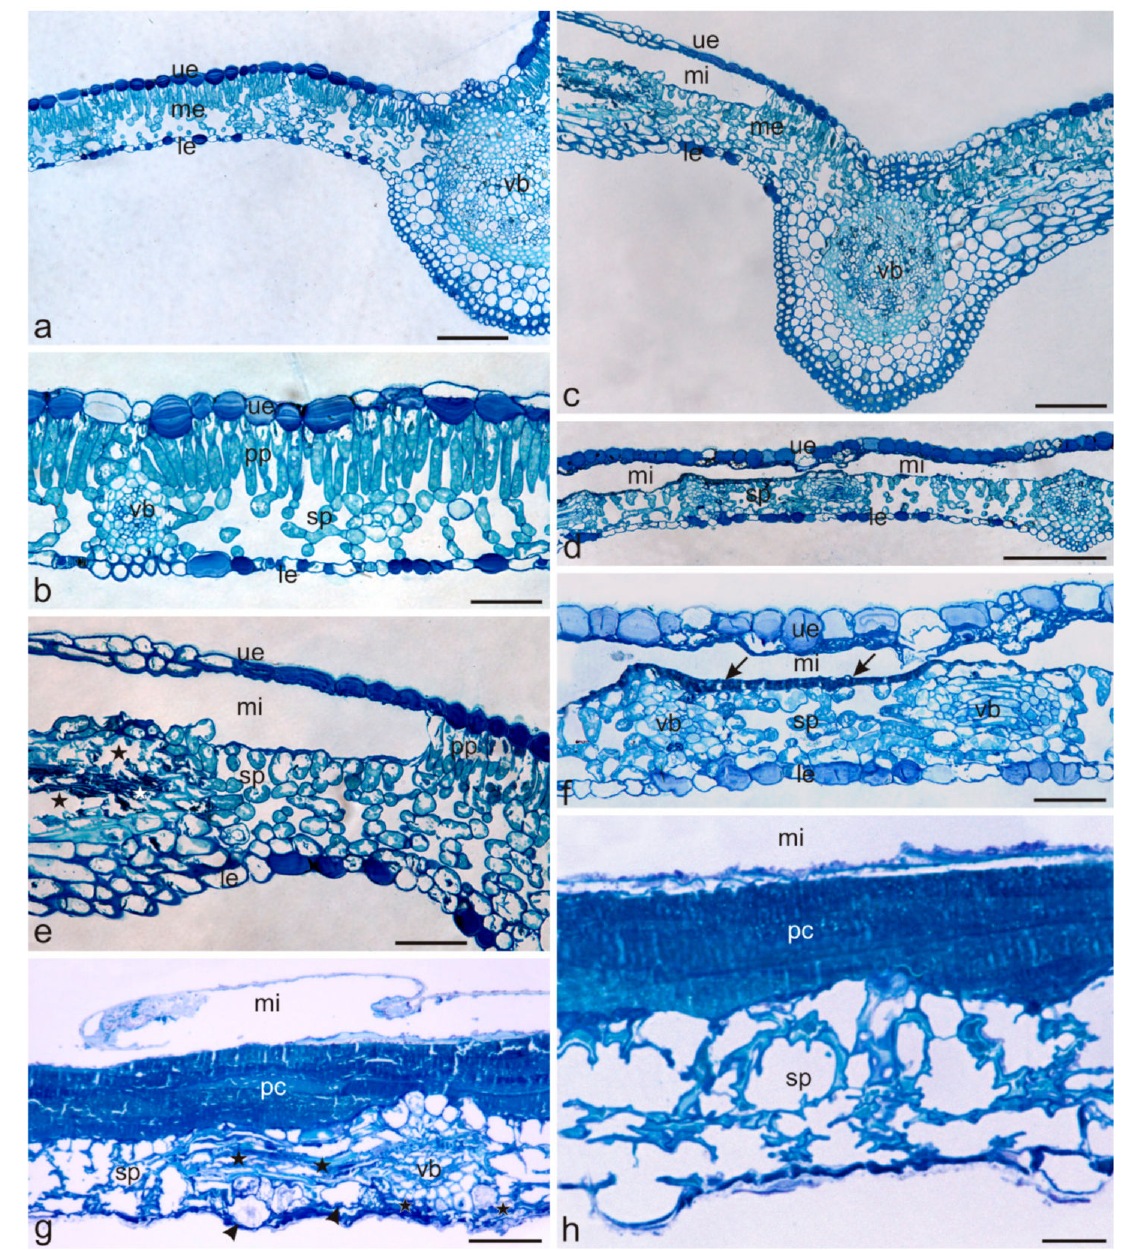
Figure 5. Cross-sections of Cameraria ohridella -infested and uninfested Aesculus hippocastanum leaves. ( a , b ) Uninfested (healthy) leaves with the adaxial (upper) and abaxial (lower) epidermis, mesophyll composed of a palisade and spongy parenchyma, and collateral vascular bundles. ( c – f ) Infested (damaged) leaves collected in July. ( c , d ) Visible mines at the sites of foraged palisade parenchyma. ( e ) Damaged spongy parenchyma cell walls in the vicinity of the mine (asterisks). ( f ), A thin, dark blue layer containing phenolic compounds visible on the bottom of the mine (arrows). ( g , h ) Infested leaves collected in September. ( g ) A substantially thickened amorphous layer containing phenolic compounds visible in the bottom of the mine. Note the cellular hypertrophy (arrows), the thick- ened walls, and the disturbed cell arrangement of the spongy parenchyma (asterisks). ( h ) Spongy parenchyma cells with cracked walls and a disturbed arrangement visible under the thickened layer containing phenolic compounds. Abbreviations: me—mesophyll, ue—upper epidermis, le—lower epidermis, pp—palisade parenchyma, sp—spongy parenchyma, vb—vascular bundles, mi—mines, pc—phenolic compounds. Scale bars: 200 µ m ( d ), 100 µ m ( a , c ), 50 µ m ( b , e – g ), 20 µ m ( h